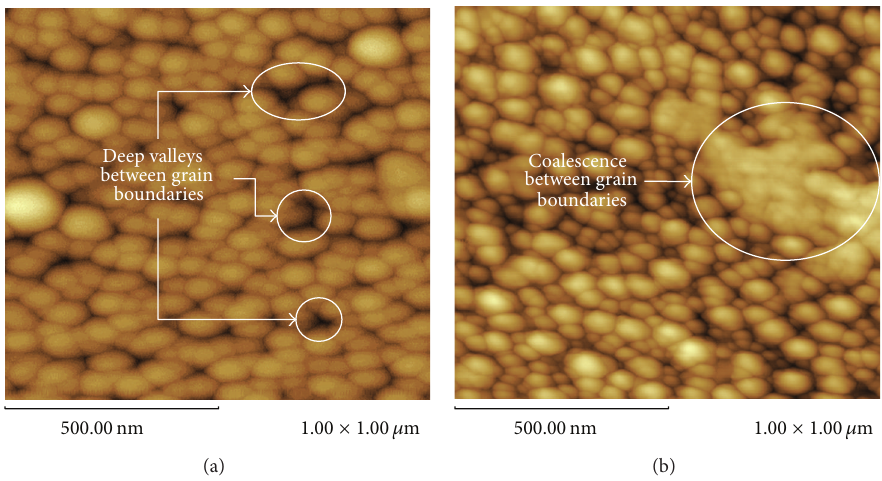
Figure 10: AFM images (1 𝜇 m × 1 𝜇 m) for films deposited at (a) 0.6 and (b) 3.5 sccm.